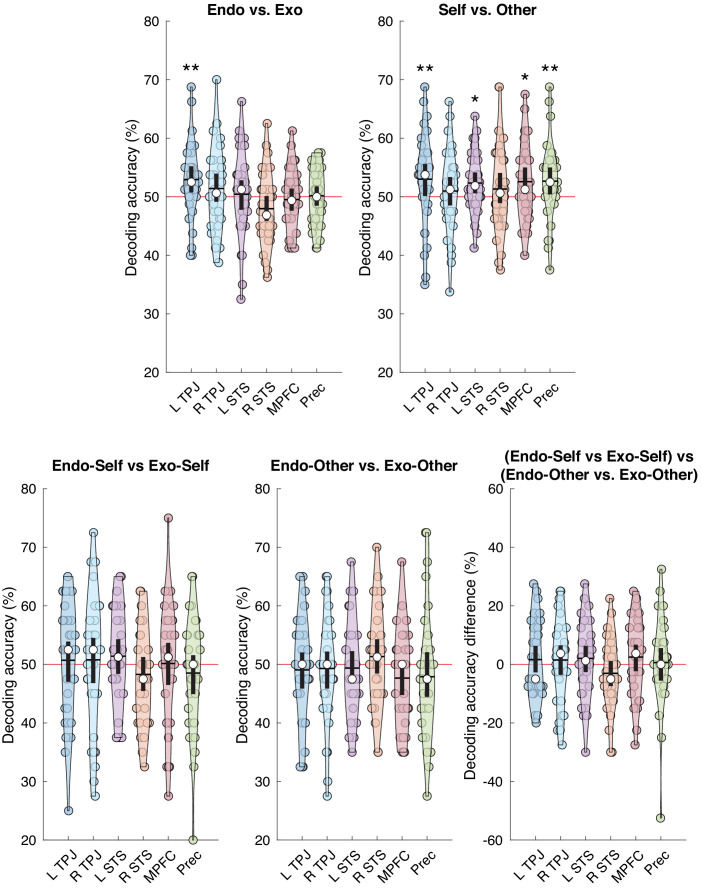
Decoding attention type, agent, and the interaction between the two, within the six ROIs.Violin plots showing mean (black horizontal line) and median (white circle) decoding accuracy (%), 95% confidence interval around the mean based on bootstrap distribution (black vertical line), a kernel density estimation (shaded area), and individual data points for each of the six ROIs. The horizontal red line indicates chance decoding. *p<0.05, **p<0.01.